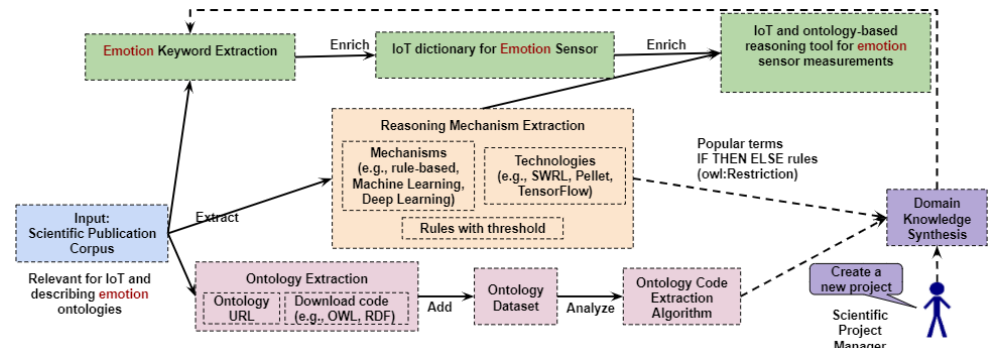
Figure 2. Knowledge extraction architecture from emotion